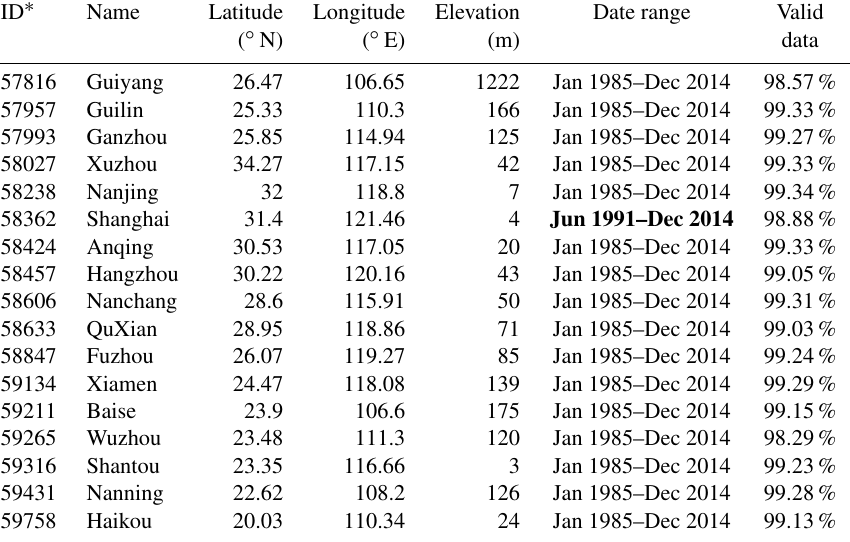
Table A1. The information of 66 stations used in this study. Date ranges are the periods when radiosonde data, daily precipitation, and daily maximum temperature are all available at the same time. The periods less than 30 years are highlighted in bold. The percentages of valid data are